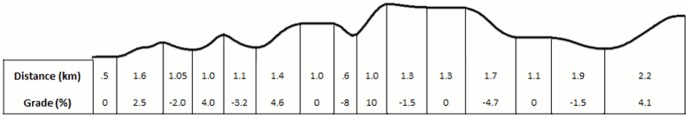
Computer simulated course showing the distances and gradient profile used in the 20-km time trial.